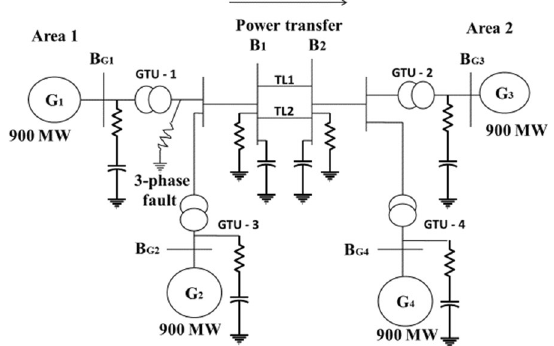
Fig. 3 Three-phase voltage waveform during unstable power